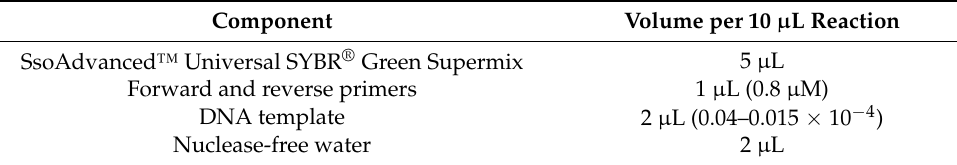
Table 2. Proportion of PCR